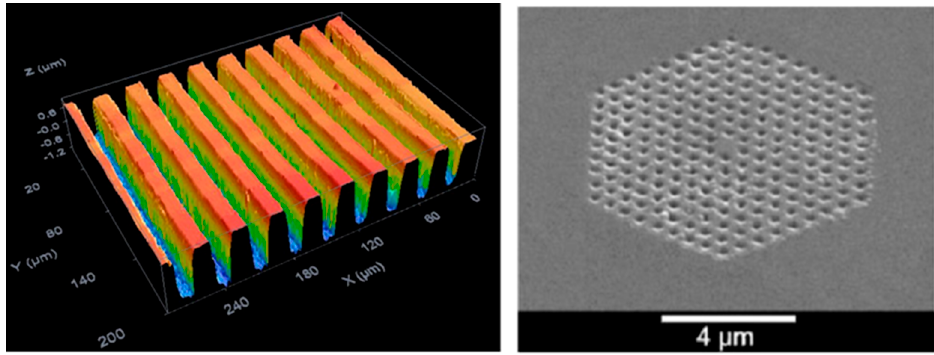
Figure 3. Laser-inscribed structures by ultrafast laser processing: confocal laser microscope image of grooves on titanium ( left ); scanning electron microscope (SEM)-picture of nano-holes on a sapphire crystal ( right ) (reprinted by permission from Springer: [17], copyright 2003).